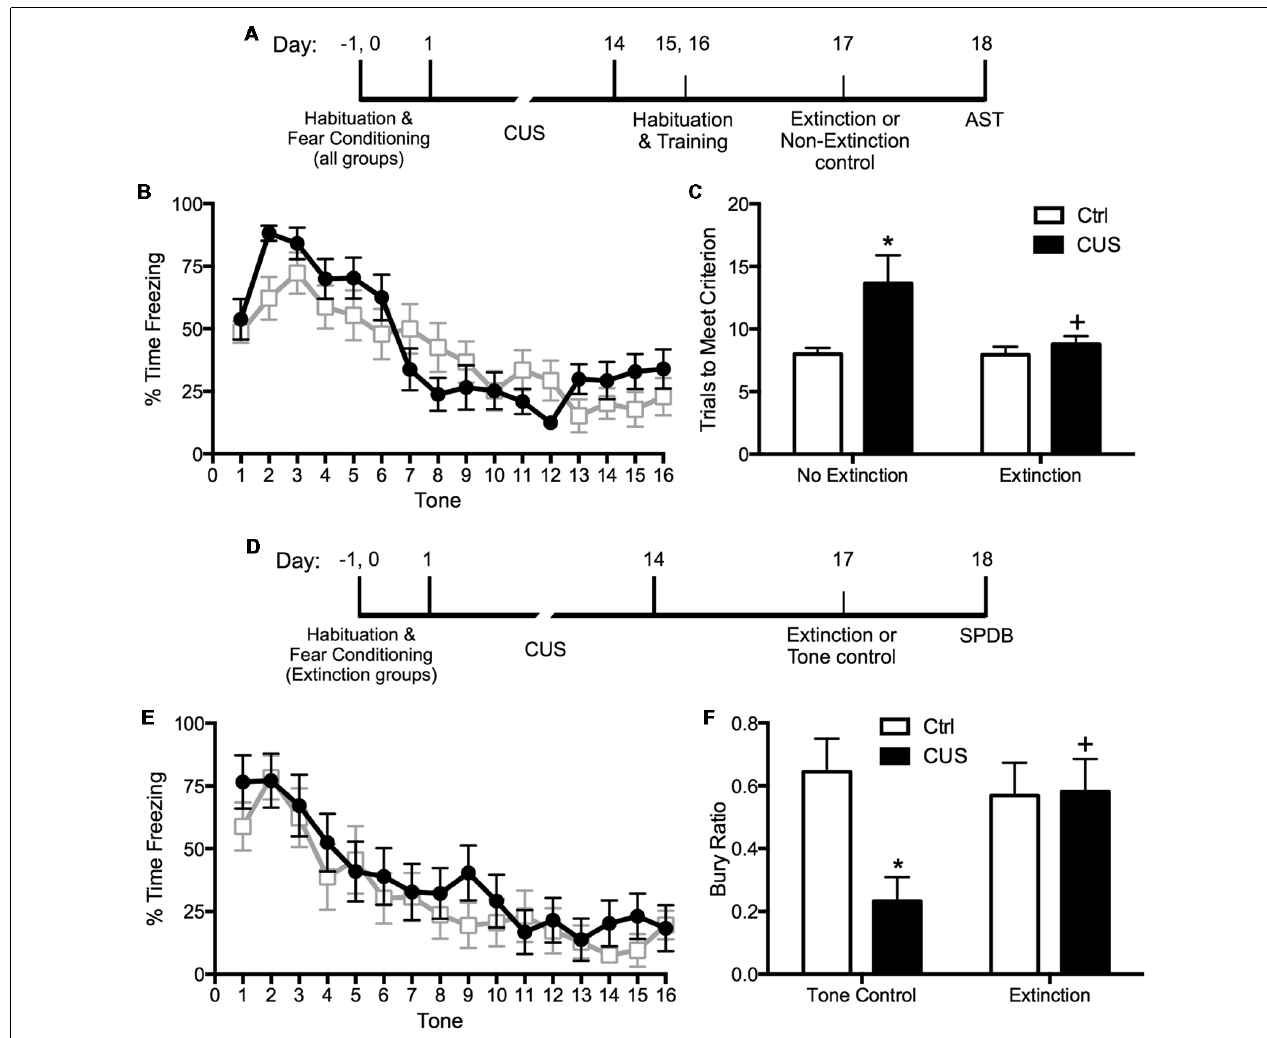
FIGURE 1 | Effects of chronic unpredictable stress (CUS) and extinction therapy on attentional set-shifting and coping behavior on the shock-probe defensive burying test (SPDB). (A) Time line for the experiment testing the effects of chronic stress and extinction therapy on cognitive set-shifting. (B) Extinction, administered 24 h before testing on the Attentional Set-shifting Test (AST), was comparable in the two extinction treatment groups (CUS and unstressed control; area under the curves, p > 0.65); n = 14 per group. (C) CUS induced a significant increase in the number of trials required to meet criterion (TTC) of six consecutive correct responses on the set-shifting task ( ∗ p < 0.05, CUS compared to unstressed controls in the non-extinction groups). Extinction treatment reversed the effect of stress, restoring performance to unstressed control levels ( + p < 0.05, extinction compared to non-extinction in the CUS groups); n = 14–15 per group. (D) Time line for the experiment testing the effects of chronic stress and extinction therapy on coping behavior. (E) Extinction, administered 24 h before testing on the shock probe test, was comparable in the two extinction treatment groups (CUS and unstressed control; area under the curves, p > 0.55); n = 12 per group. Extinction control groups exposed to tone presentation but not fear conditioned (“Tone controls”) showed low levels of freezing during tone presentation (not shown). (F) CUS induced a significant decrease in the Bury Ratio [calculated as bury time/(bury time + immobility time)]; ∗ p < 0.05, CUS tone controls compared to unstressed tone controls). Extinction treatment reversed the effect of stress, restoring the Bury Ratio to unstressed control levels ( + p < 0.05, CUS-extinction compared to CUS-tone controls); n = 11–12 per group. Data expressed as mean ± SEM. Reproduced and adapted with permission from Fucich et al. (2016).